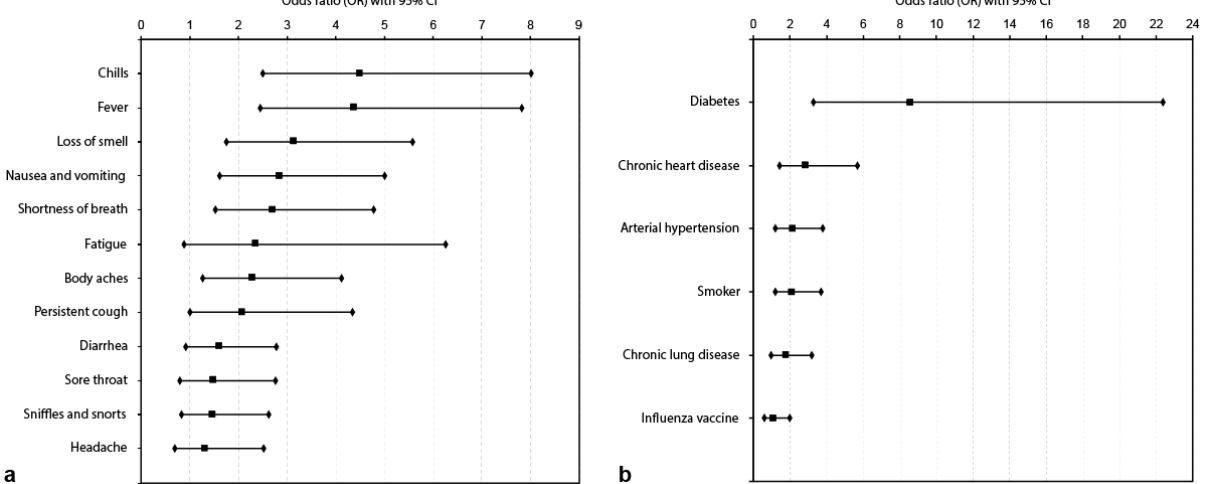
Figure 2. (a) Association between reported symptoms and the odds ratio for a positive SARS-CoV-2 test result; (b) association between reported risk factors and the odds ratio for a positive SARS-CoV-2 test result. Both analyses were carried out in a population of 291 participants who tested via reverse transcription-polymerase chain reaction. Error bars represent 95%